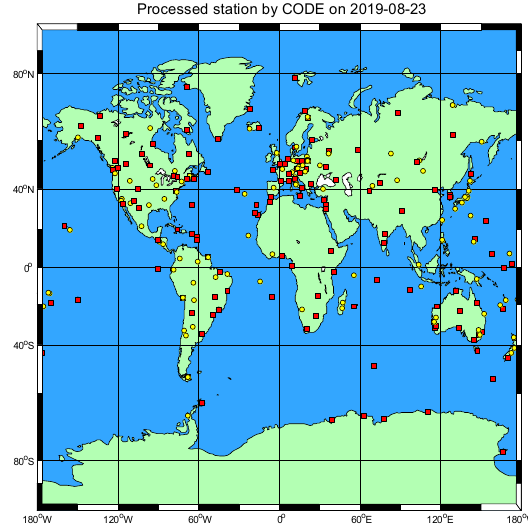
Figure 2 Processed station by CODE on 23 rd August 2019